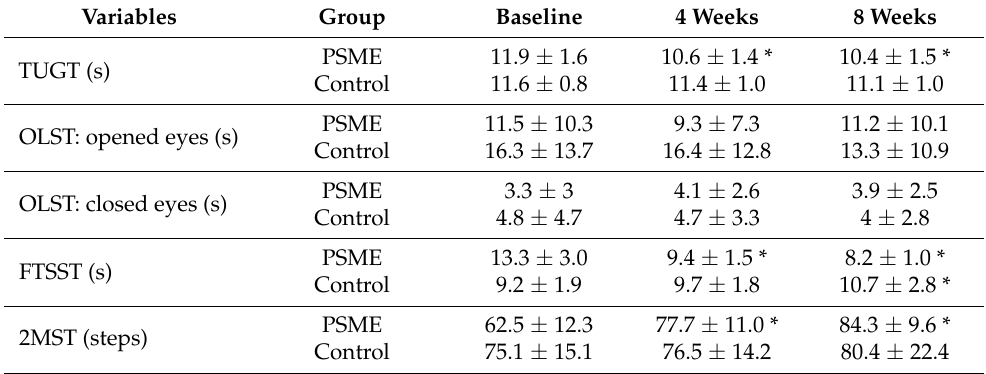
Table 3. The comparison of outcomes within the 2 groups at baseline, 4 weeks, and 8 weeks.